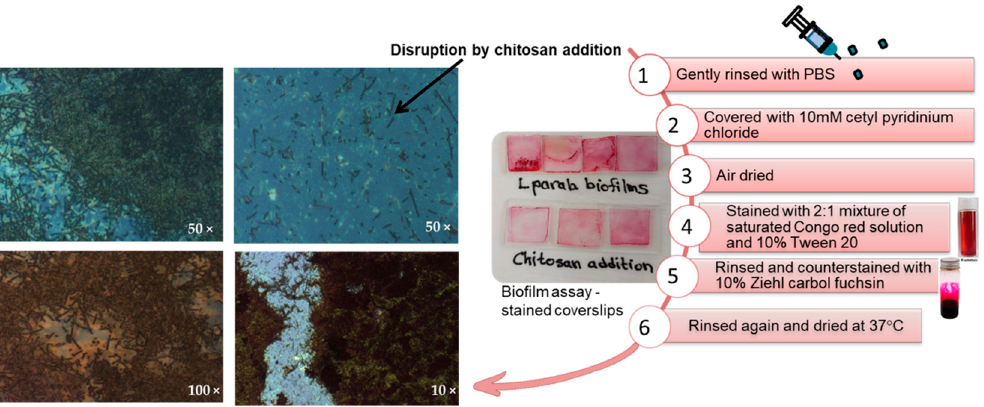
Figure 8. Optical micrograms of L. parabuchneri Gram staining. Congo Red-stained L. parabuchneri biofilms were grown for 10 days on glass coverslips and inhibited by the addition of a 0.05% chitosan stock solution.